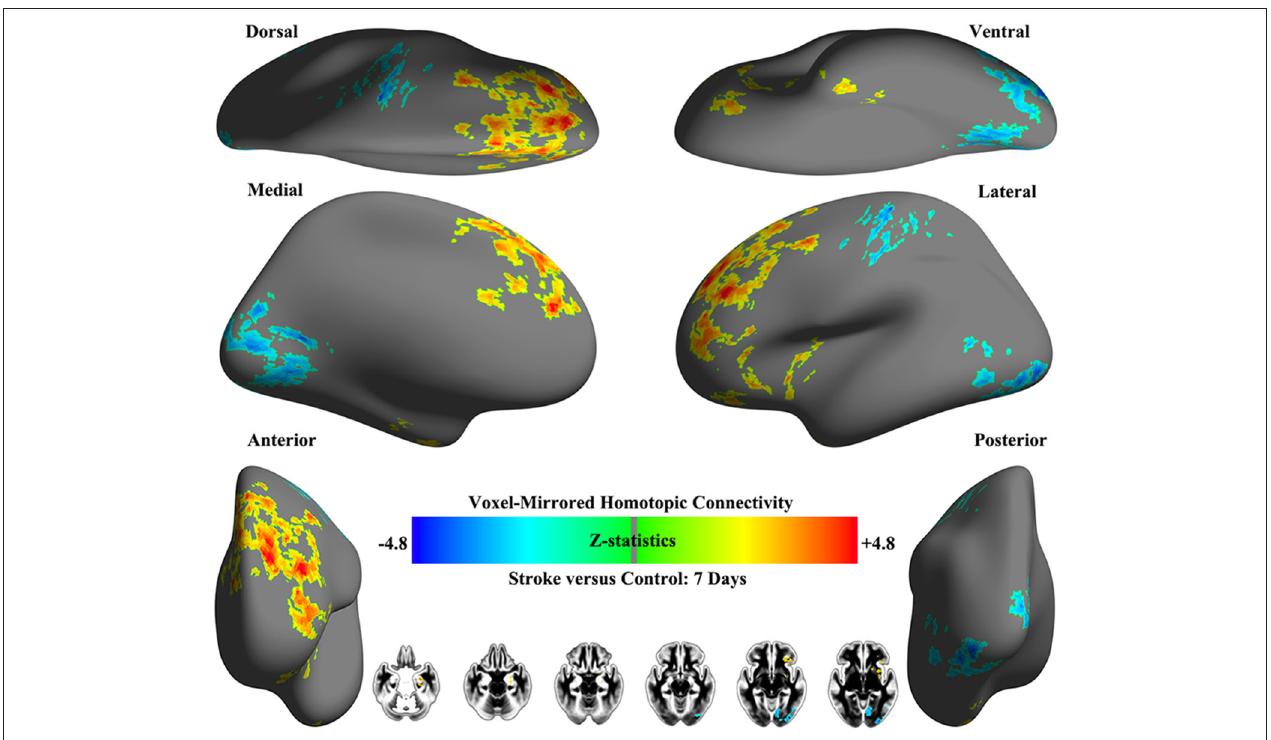
FIGURE 3 | Whole-brain surface renderings of group differences in VMHC between patients (within 7 days after stroke onset) and healthy controls. Z-statistic maps (Minimum Z > 2.3; cluster level, p = 0.05, corrected) are pictured as 6 hemispheric surfaces (cortical regions) and 6 symmetric axial slices (subcortical regions). Warm color indicates brain areas with increased VMHC in patients with stroke while cold color indicates brain areas with decreased VMHC compared with healthy controls.